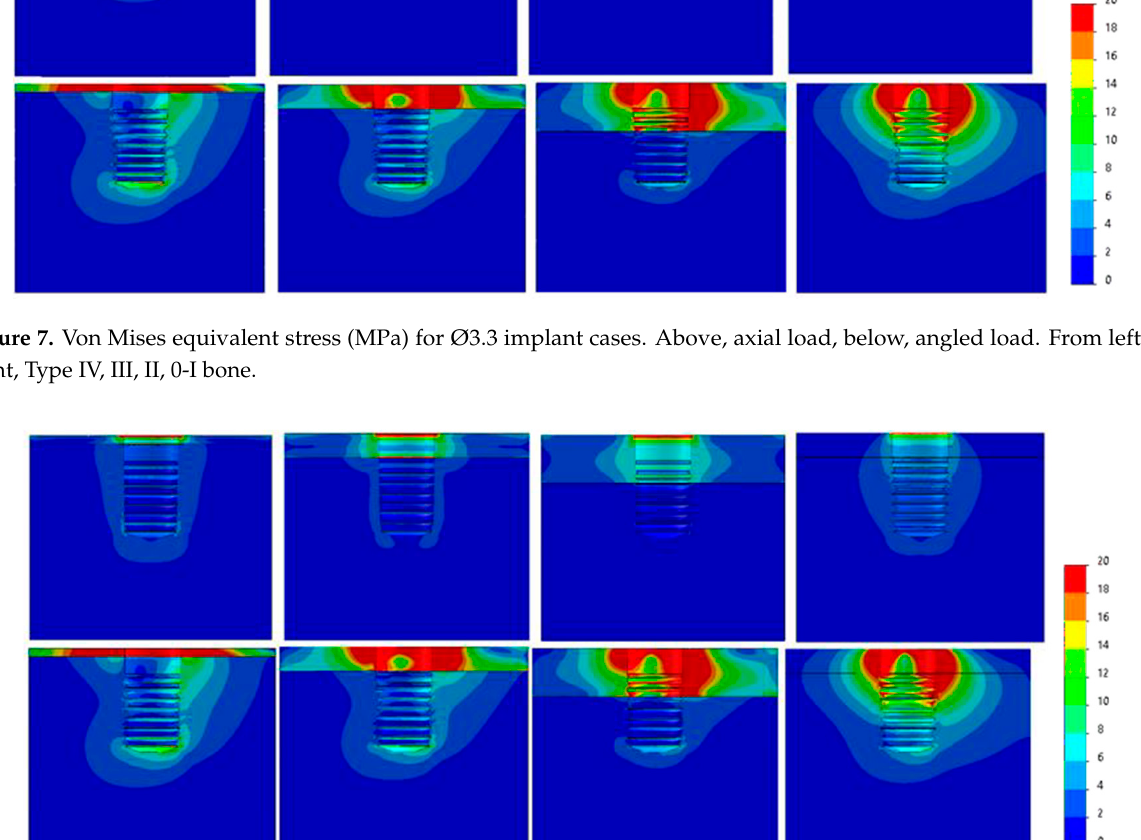
Figure 8. Von Mises equivalent stress (MPa) for Ø3.5 implant cases. Above, axial load, below, angled load. From left to right, Type IV, III, II, 0-I bone.